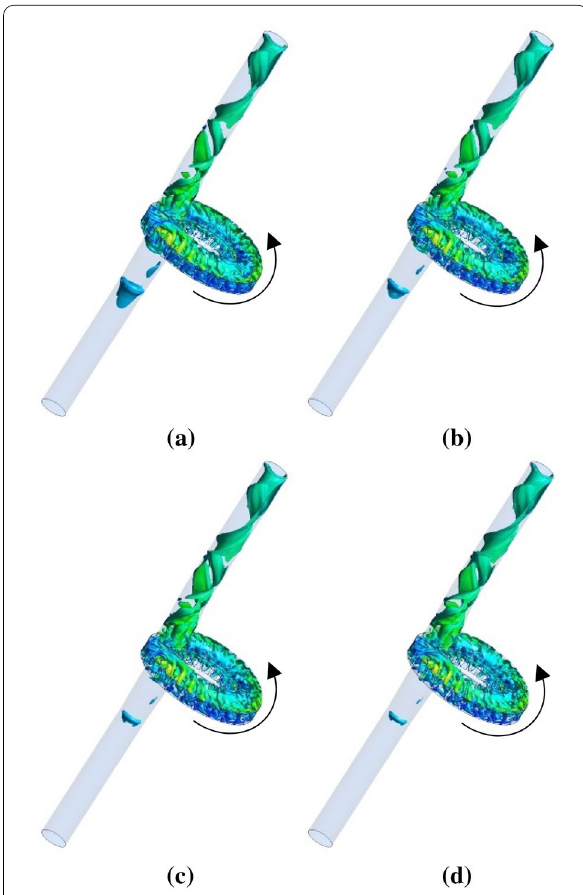
Figure 9 Vortex structures under different Ω thresholds ( a ) Ω ( b ) Ω 0.56, ( c ) Ω =